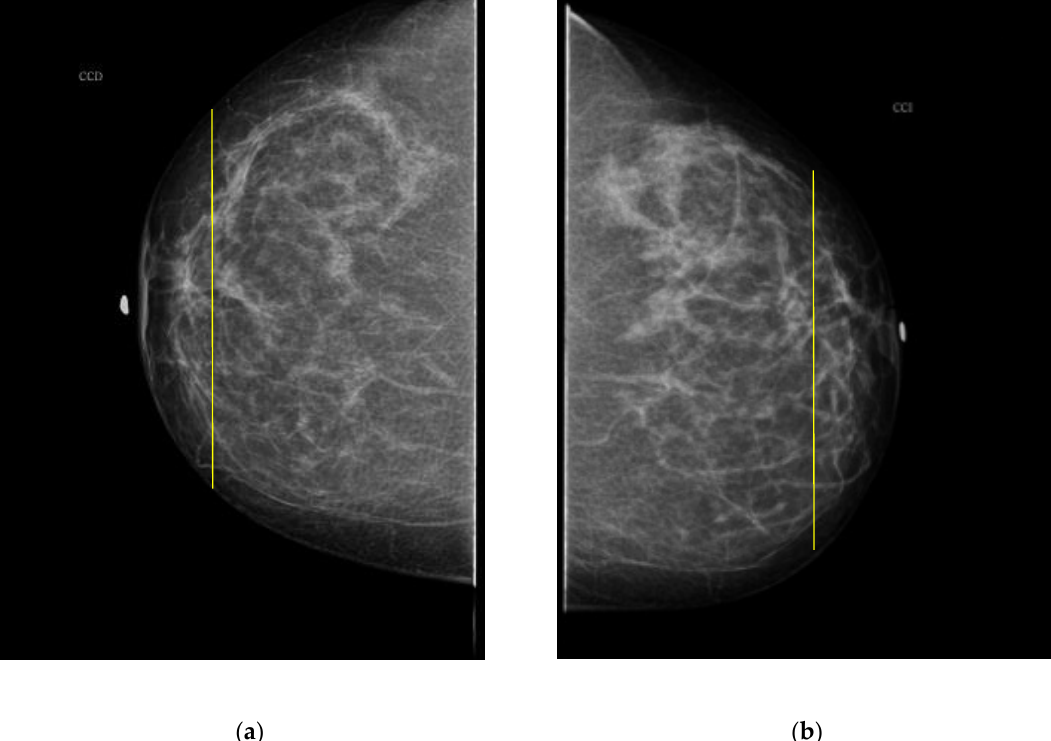
Figure 10. CC mammogram images of participant 12 and relative electrode ring position (yellow vertical line): ( a ) right breast; ( b ) left breast.